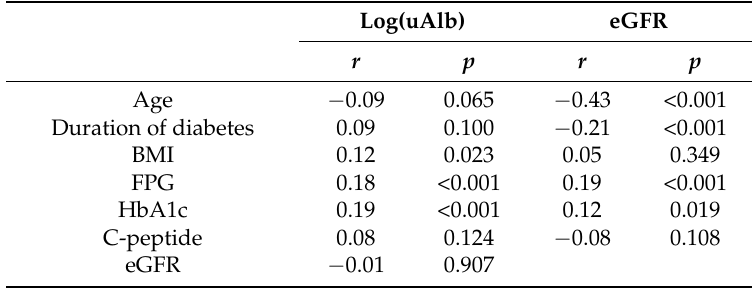
Table 2. Correlation of urinary albumin and eGFR with background characteristics.